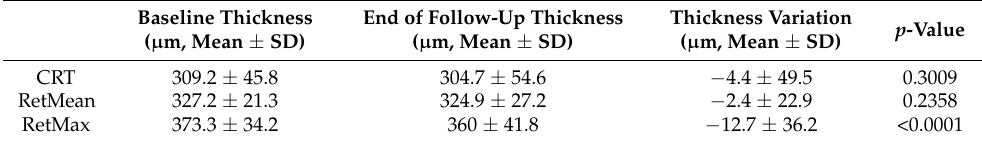
Table 2. Morphologic results (whole follow-up).